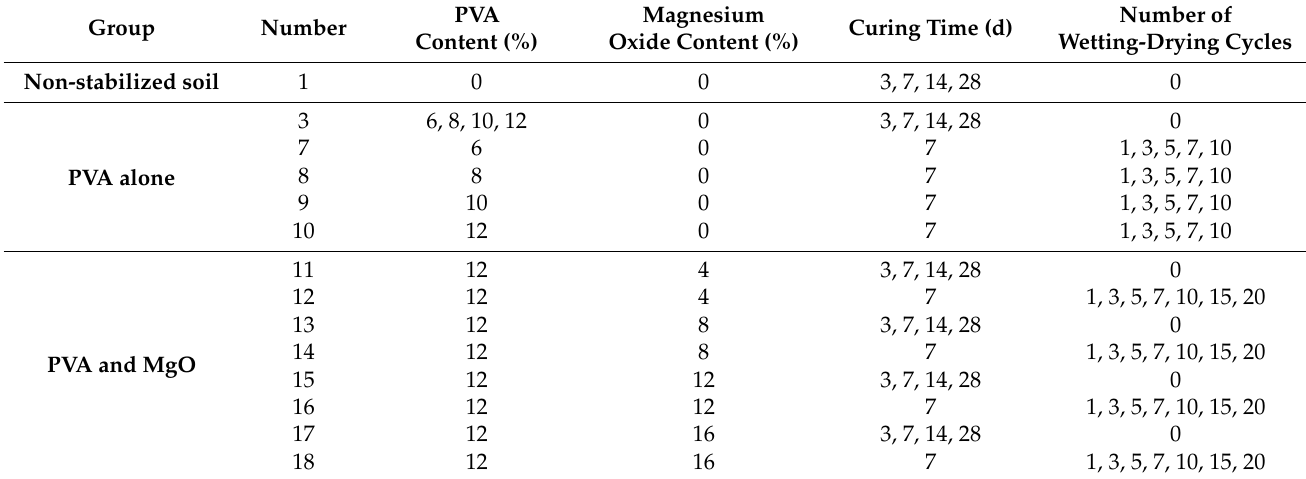
Table 2. Details of test